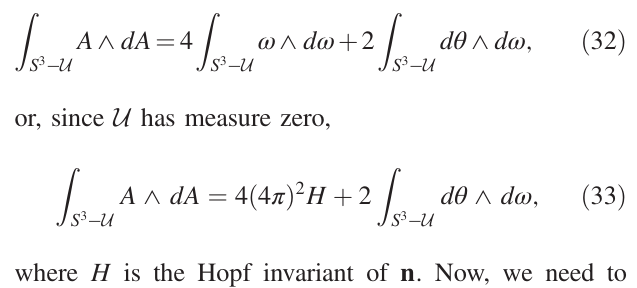
FIG. 9. Umbilic lines in the Hopf fibration. Top: Umbilic lines given as isosurfaces of j Δ j for a simulated Hopf fibration. The two lines in the midplane of the cell are both generic, with the same orientation. For symmetry reasons the central umbilic is not generic and has s ¼ 2 . On the boundary of the cell n is uniform, which means that the Hopf invariant is well defined. Note that the system is totally umbilic on the boundary. If you compactify the domain by collapsing the boundary to a point, then one can interpret the central vertical umbilic line as passing through this point. Bottom left: Director field for the Hopf texture. Bottom right: Schematic of the relationship between umbilic lines in S 3 . Two generic s ¼ 1 umbilic lines each link with one s ¼ 2 umbilic line that passes through the point at